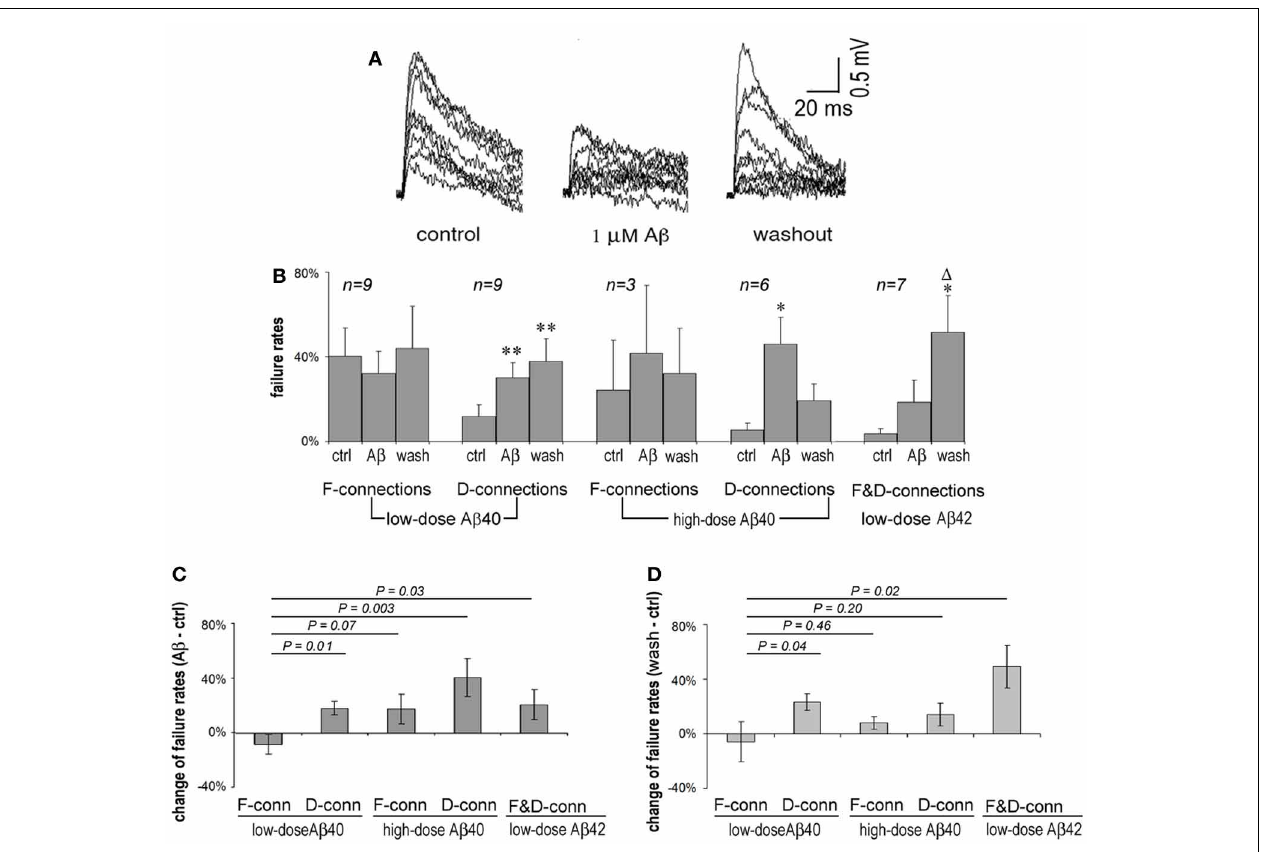
FIGURE 2 | Synaptic failure rates vary according to synaptic type and upon A β species and concentration. (A) Superimposed 15 single EPSP traces recorded at 0.5Hz from an F-type connection in pre-application, application and washout phases of 1 μ M A β 40. EPSPs were generally reduced and the number of failures increased during application of A β for 20min, which tended to recover on washout for 10min. (B) Average failure rates of F- and D-connections in pre-application, application and washout phases in the presence of A β were charted according to A β species and concentration, and connection type. The synaptic failure rate tended to decrease in F-connections after low-dose A β 40 applied. In contrast, the failure rates appear to increase in all other cases. Low and high doses of A β 40 applied to D-connections reached significance ( P = 0.01 and P = 0.024, respectively). A trend to enhance failure rates is shown in the case of high-dose A β 40 to F-connection ( n = 4) and low-dose A β 42 to F- ( n = 3) and D-( n = 4) connections. After washout for 10–30min., the failure rate are